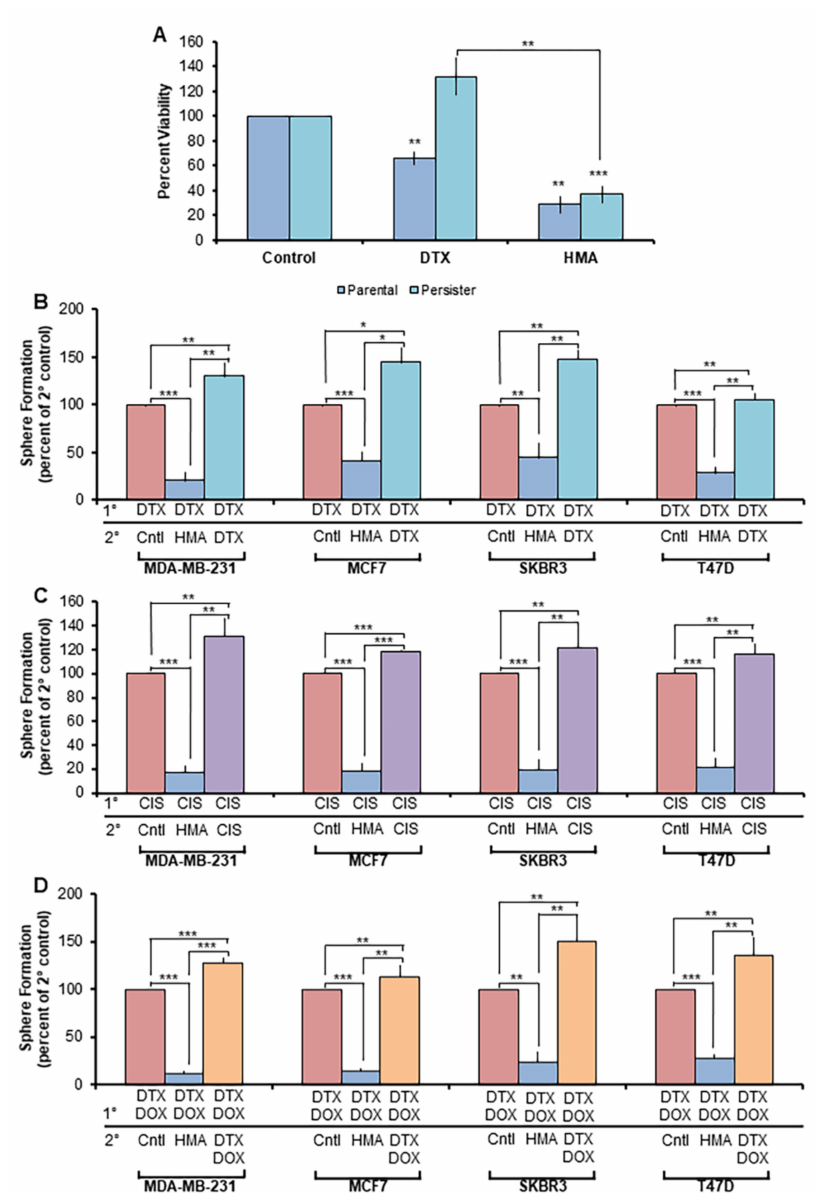
Figure 2. HMA is cytotoxic toward tumor cell populations insensitive to conventional chemother- apeutics. ( A ) Parental and DTX persister cells were treated with vehicle, 4 µ M DTX, or 40 µ M HMA for 24 h, and trypan blue exclusion assay was used to assess cell viability. Data are rep- resentative of five biological replicate experiments. ( B – D ) Breast cancer cell lines were treated with primary (1 ◦ ) chemotherapy treatments—( B ) 100 nM DTX, ( C ) 40 µ M CIS, and ( D ) 170 nM DOX/50 nM DTX—for 72 h and then plated in serum-free, low-adherent conditions to enrich for the chemotherapy-insensitive BCSC population. Cells were subsequently treated with vehicle, 40 µ M HMA, or a secondary (2 ◦ ) chemotherapeutic treatment. Average sphere count was assessed after 7 days. Data are representative of three independent studies. Error bars represent SEM. *, p < 0.05; **, p < 0.01; ***, p < 0.001, by Student’s t